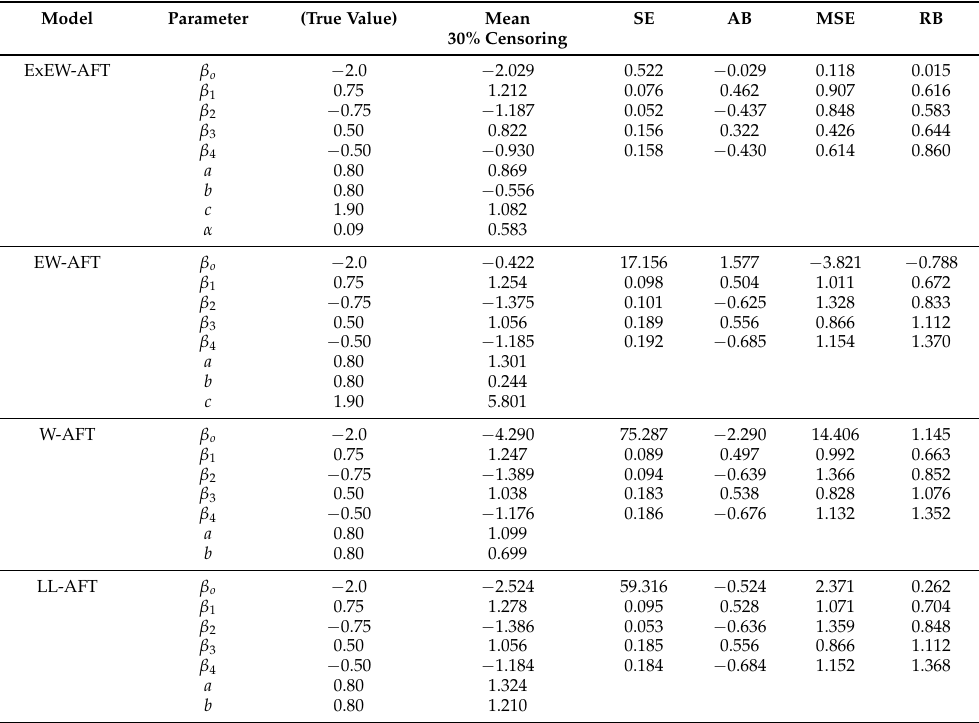
Table 7. Simulation study for scenario 2 ( n = 1000) with about 30% censored observations is used to compare model performance.